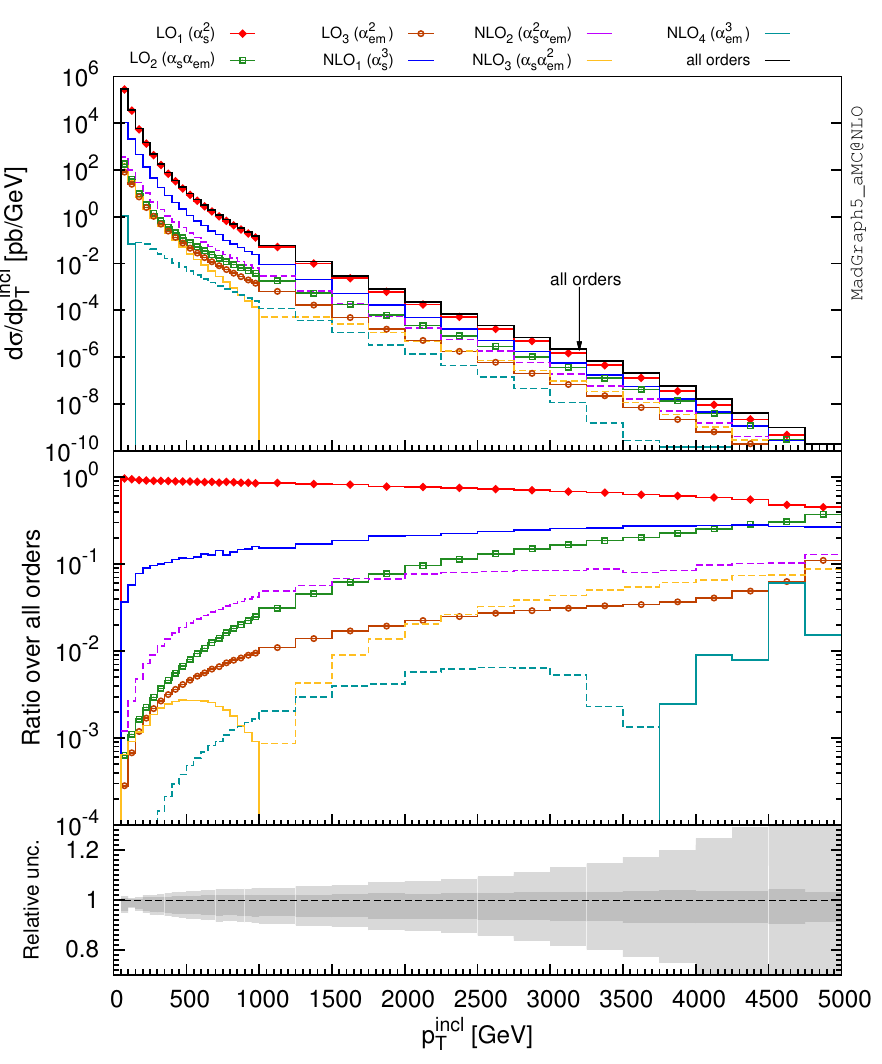
Figure 2 . Single-inclusive transverse